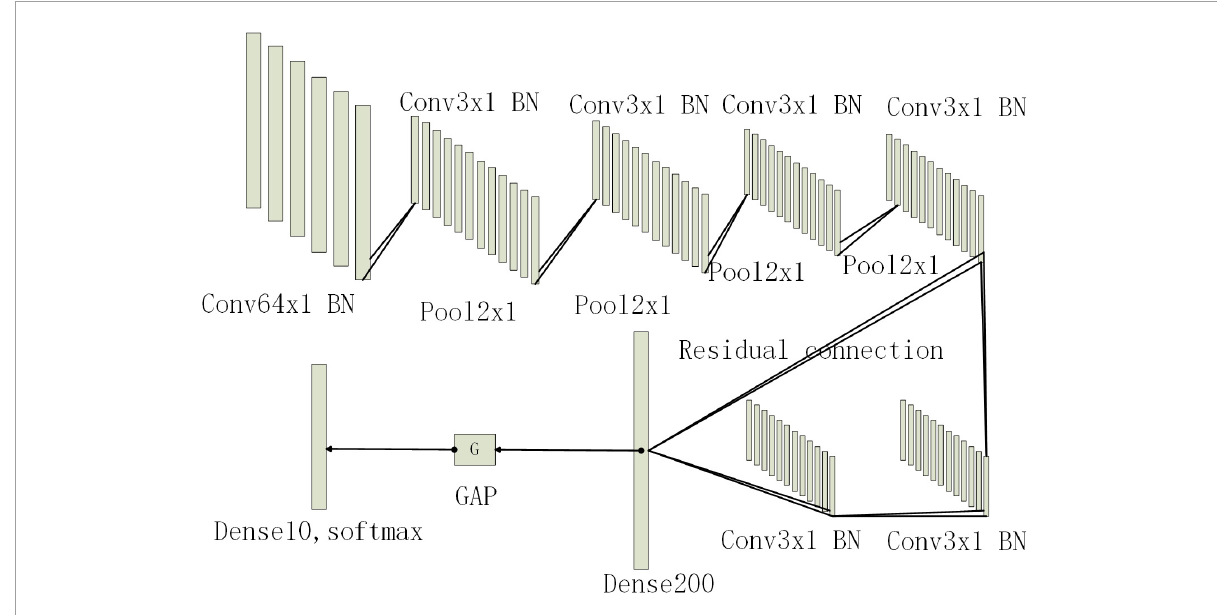
FIGURE1 Network structure